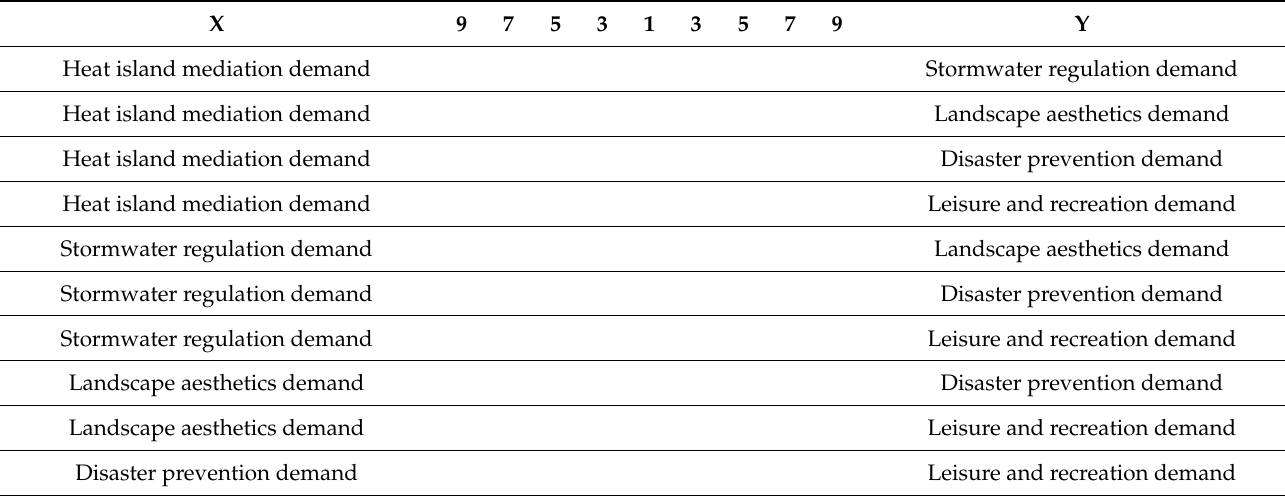
Table A5. Importance comparison of urban demand of brownfield